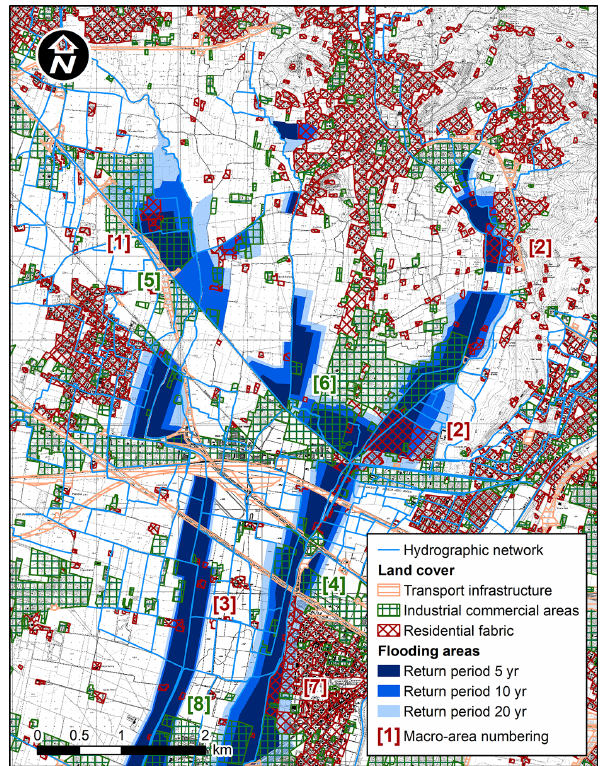
Figure 2. Flooding-hazard map of the study area comparing present land cover and flooding-area extensions referring to return peri- ods varying between 5 and 20 years; exposed residential areas are (1) Laorna and Gandovere streams, (2) La Canale and Solda streams, (3) southern Gandovere canal, and (7) Mandolossa canal, and exposed industrial and commercial settlements are (4) Man- dolossa canal, (5) Laorna and Gandovere streams, (6) La Canale and Solda streams, and (8) southern Gandovere canal; the base map is the Lombardy Regional Technical Map (CTR), 1 : 5000, provided by the Lombardy Region (http://www.geoportale.regione. lombardia.it/, last access: 3 March